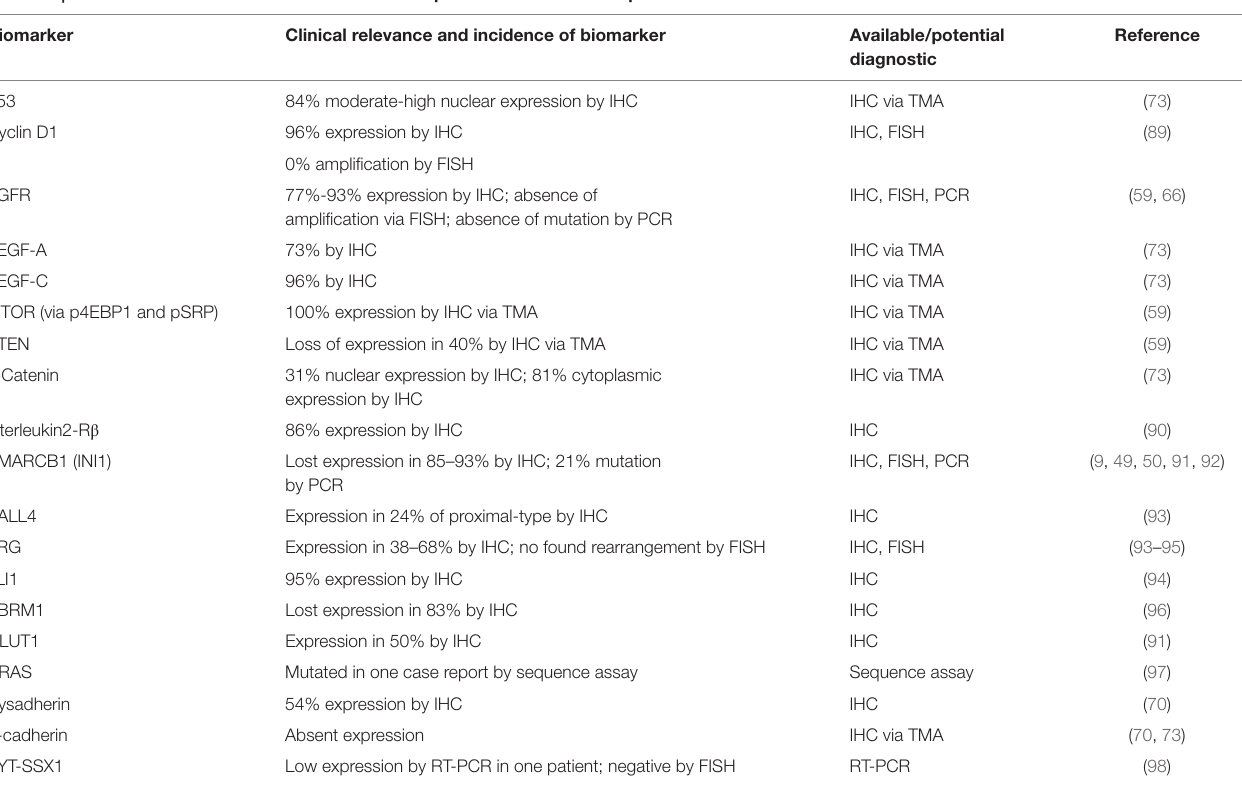
TABLe 1 | Potential actionable biomarkers in clinical epithelioid sarcoma samples. Biomarker Clinical relevance and incidence of biomarker Available/potential